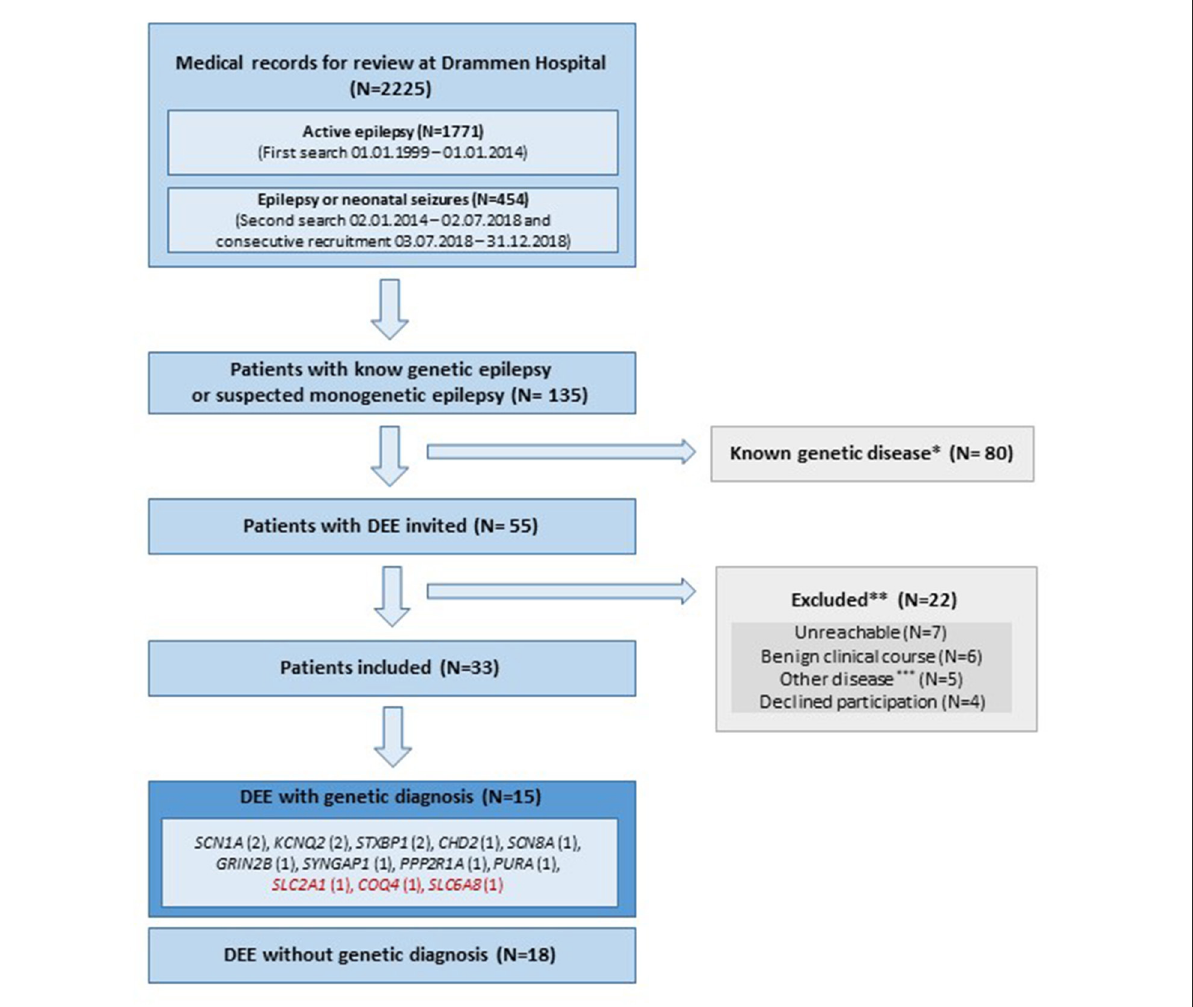
FIGURE1 Flowchart of inclusion and exclusion of patients. DEE, Developmental and epileptic encephalopathy; N, number of subjects; Red color, treatable disease; * , Supplementary Table 1. Patients given a genetic diagnoses prior to 2014 and therefore not invited. ** , 3/22 of the excluded patients were diagnosed with a genetic cause of disease (SCN1A, AMT, SCN2A); *** , Other disease includes; three patients with structural lesions explaining epilepsy and two with autism spectrum disorder and self-limiting